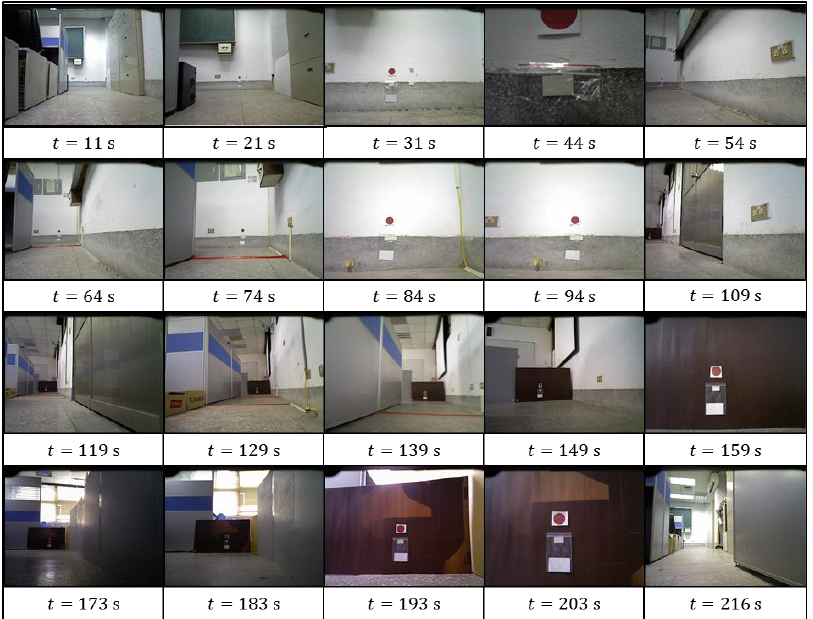
Figure 10. Color image recorded by SVS during the patrol task.